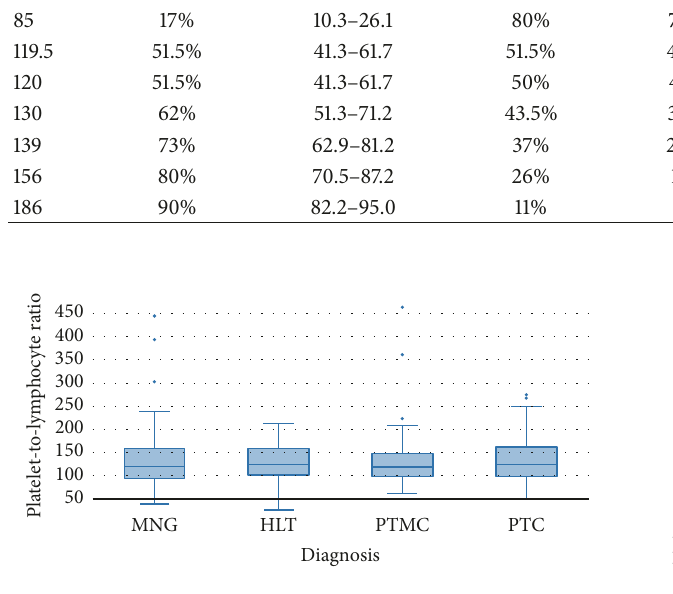
Figure 2: Comparison of platelet-to-lymphocyte ratio (mean ± SD) among the subgroups MNG, HLT, PTMC, and PTC.